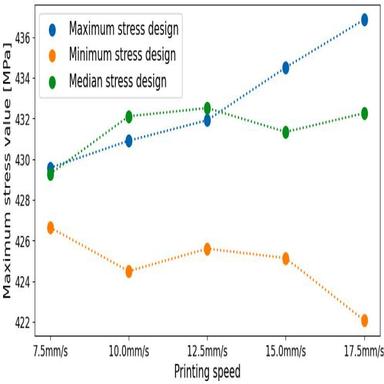
Residual stress values of three designs.